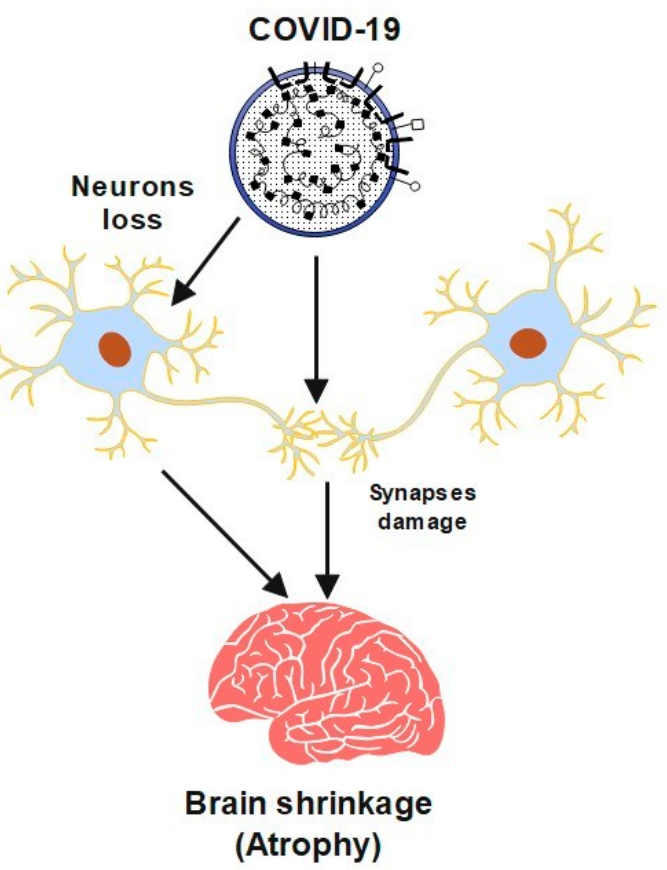
Figure 1. A schematic diagram of COVID-19 effects brain